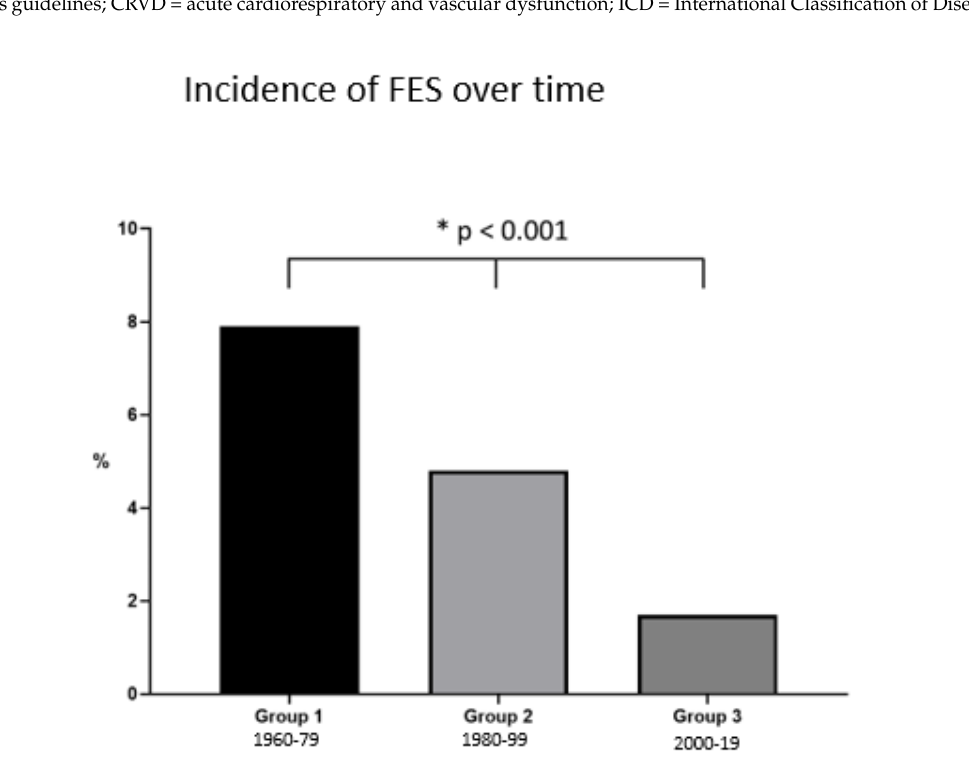
Figure 2. Incidence of clinically diagnosed FES over time (level of significance gr1 versus gr2 and gr2 versus gr3).